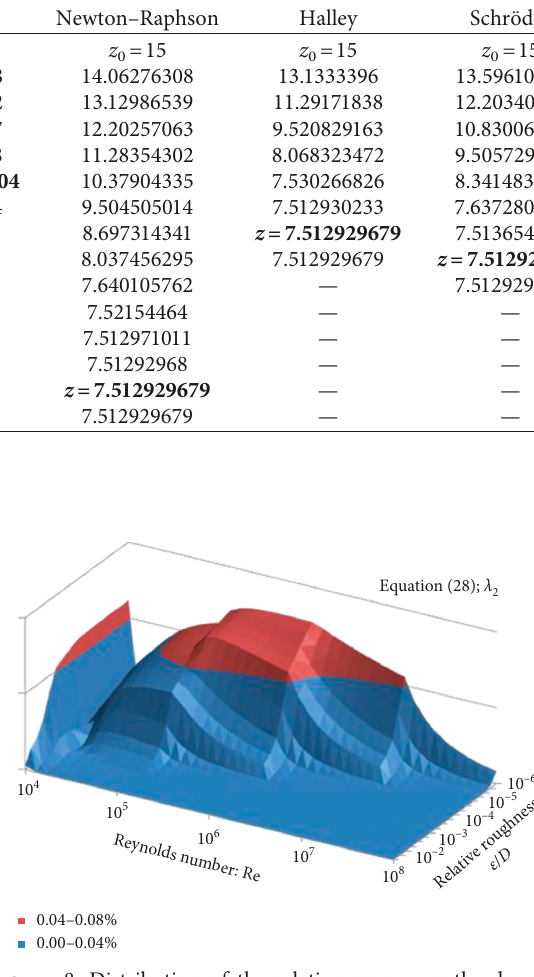
3 10 4 , y Re/2.18 13760.47 (cid:31) · (cid:31) (cid:31)